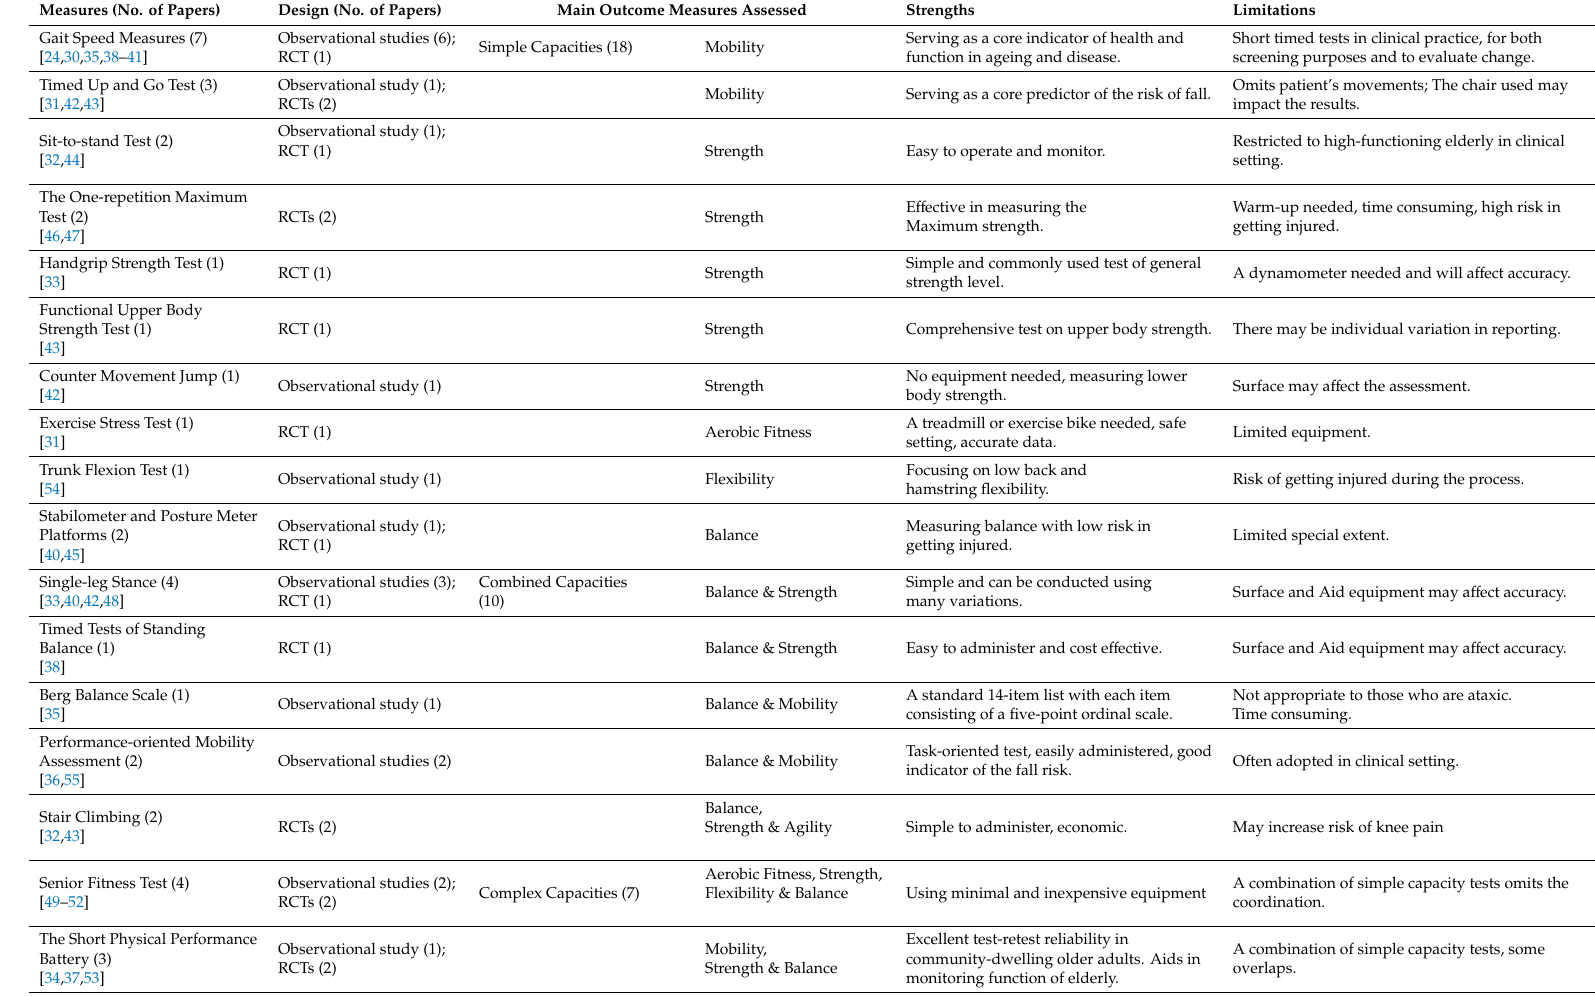
Table 5. Critical analysis of the objective measures of physical competence within physical literacy for older